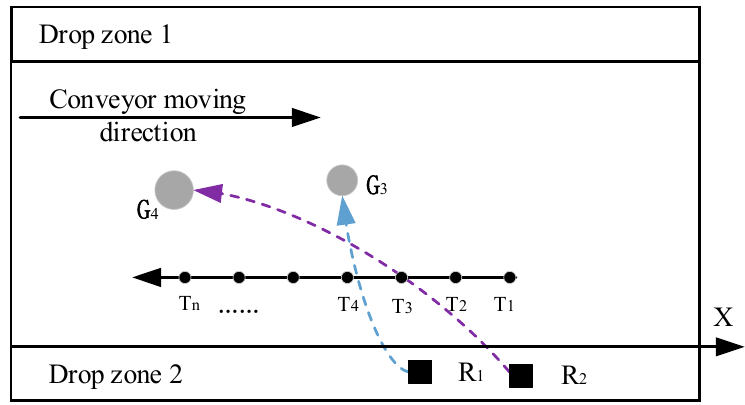
Figure 11. Schematic diagram of task conflict between two robotic arms.